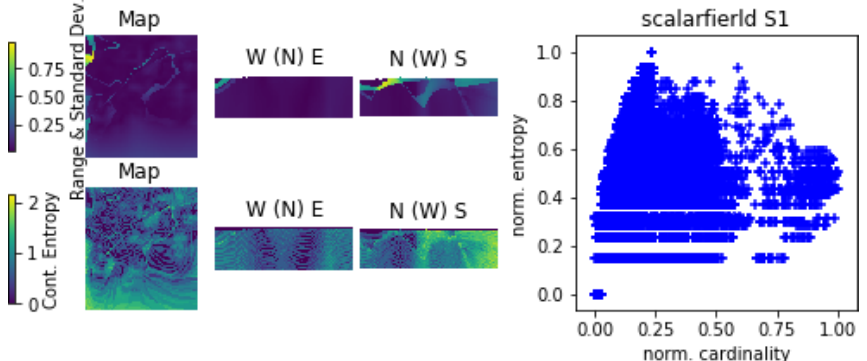
Figure 15. Comparison of local uncertainty measures for an ensemble of 10 scalar-field 3D voxets for scenario 1; 3D visualisation looking from the NW of the voxet, the top surface of the voxet an EW section at the northern face of the model looking from the south, a NS section on the western face of the voxet looking from the